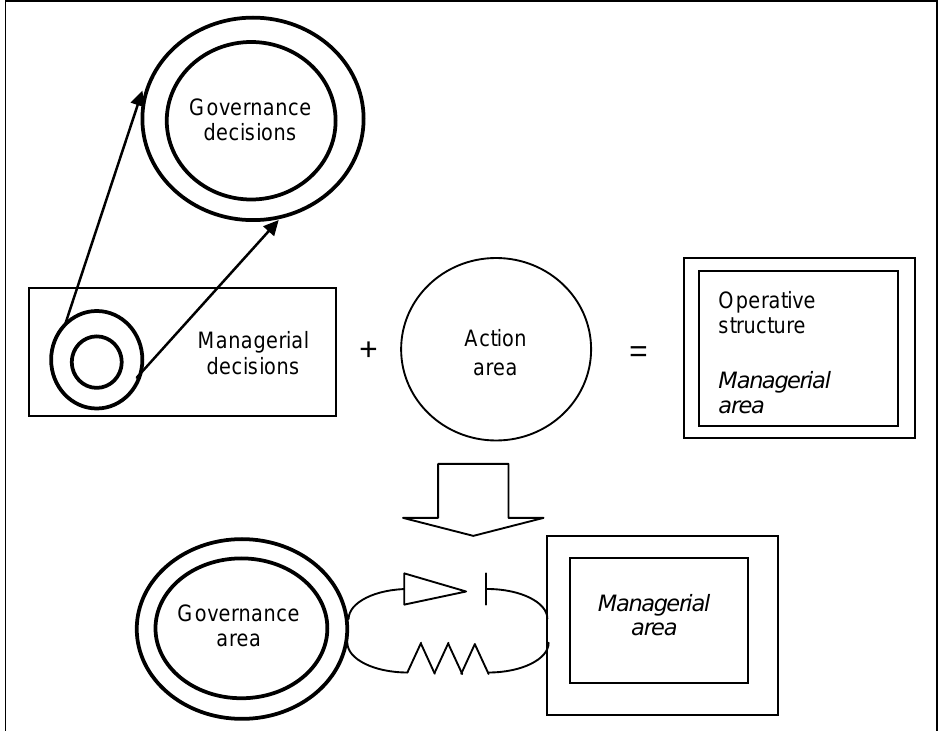
Figure 3: The Firm as a Viable System Extracted from the Viable System